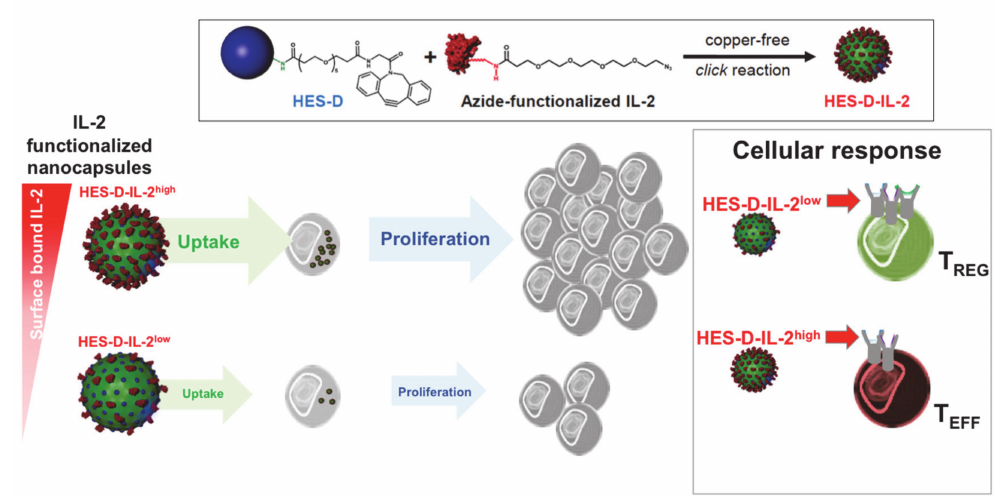
Figure 4. Bio-inspired nanoparticle-mediated IL-2 delivery strategies. Particle encapsulated IL-2 ensures a controlled release of the cytokine for treatment. Antibody-complexed IL-2 and dosed and oriented IL-2-coated particles enable receptor-specific targeting and